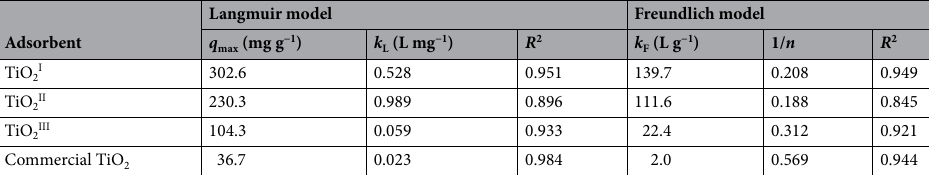
Table 1. Langmuir and Freundlich isotherms parameters for Tl(I) adsorption on the synthesized and commercial titanium dioxides at pH 7.0 ± 0.1.